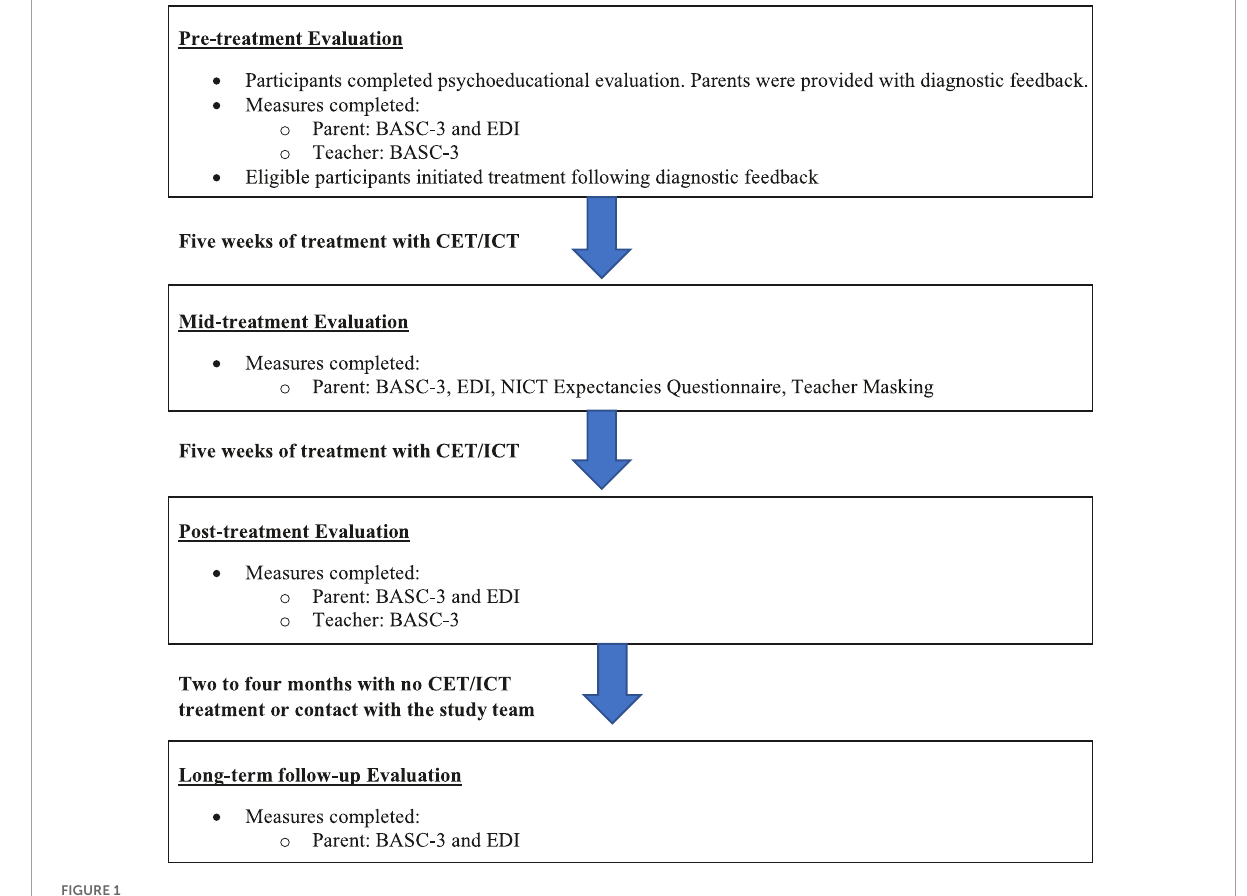
FIGURE1 Study timeline. BASC-3, behavior assessment scale for children; CET, central executive training; EDI, emotion dysregulation inventory; ICT, inhibitory control